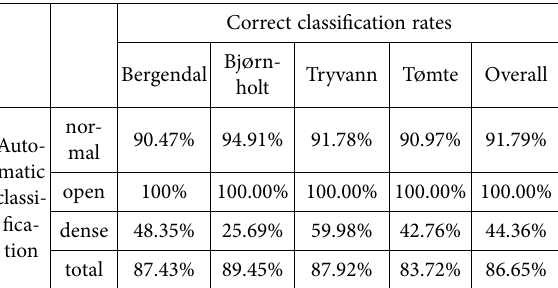
Table 9. Stipulated classification rates with the assumption that the automatic classification of open land is correct Correct classification